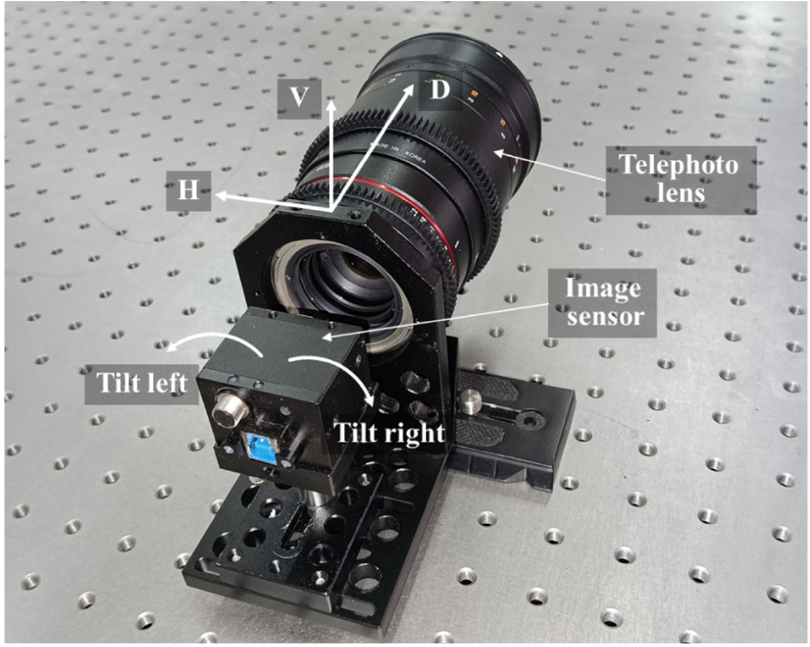
Figure 4. Scheimpflug camera.